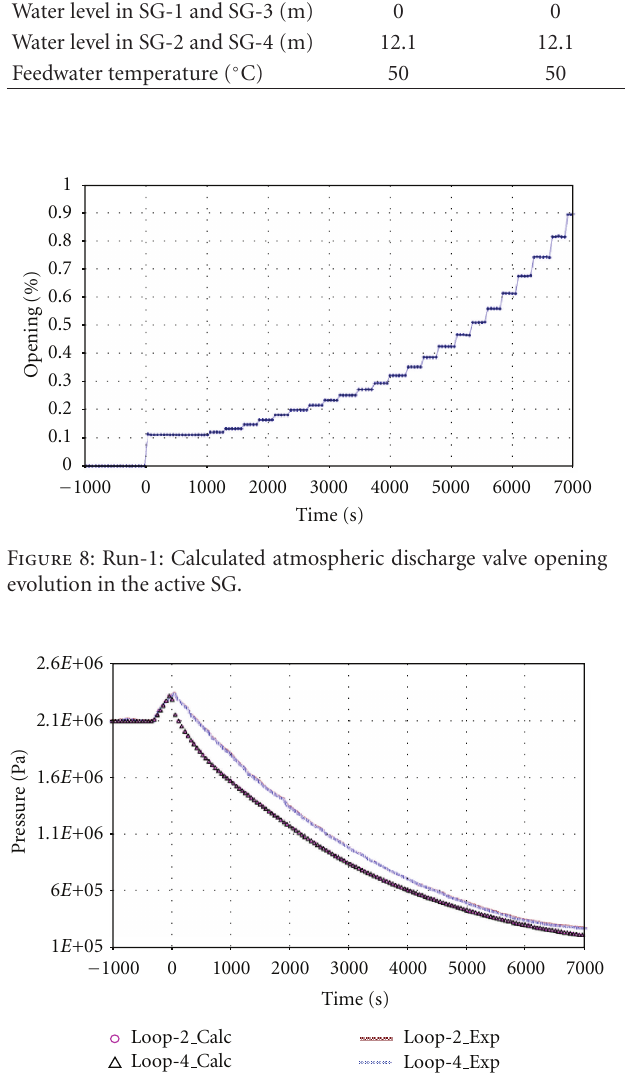
Figure 9: Run-1: Secondary side pressure evolution in the active